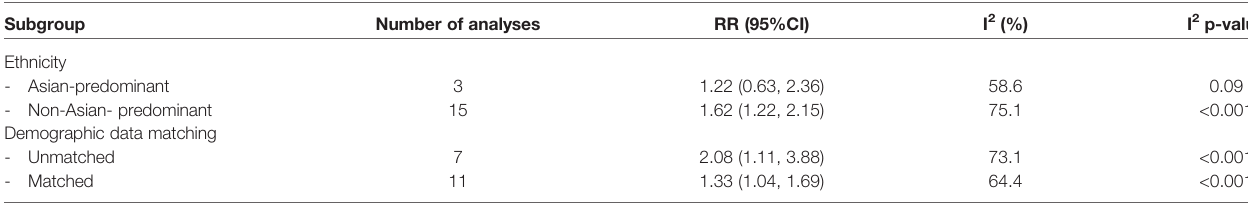
TABLE 2 | Subgroup analysis for assessment of all glycemic abnormalities between primary aldosteronism and essential hypertension patients. Subgroup